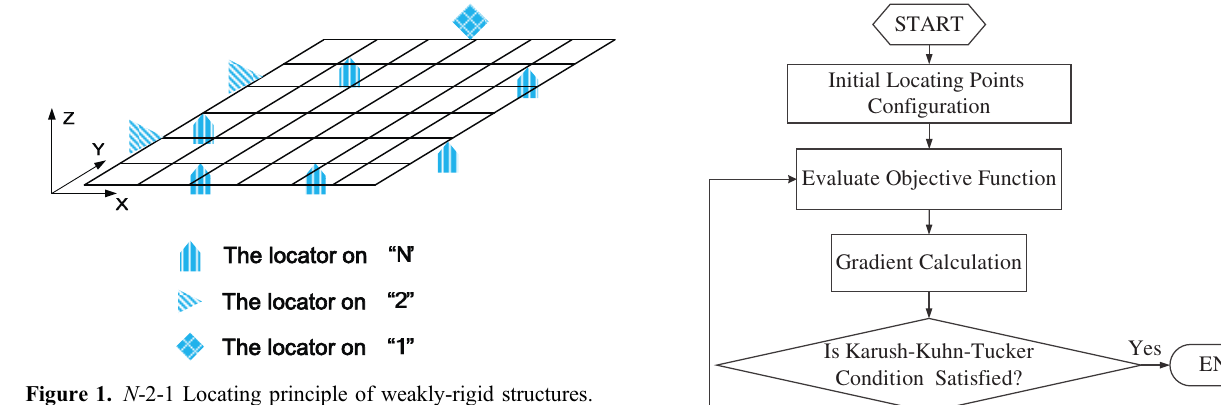
Figure 1. N -2-1 Locating principle of weakly-rigid structures.